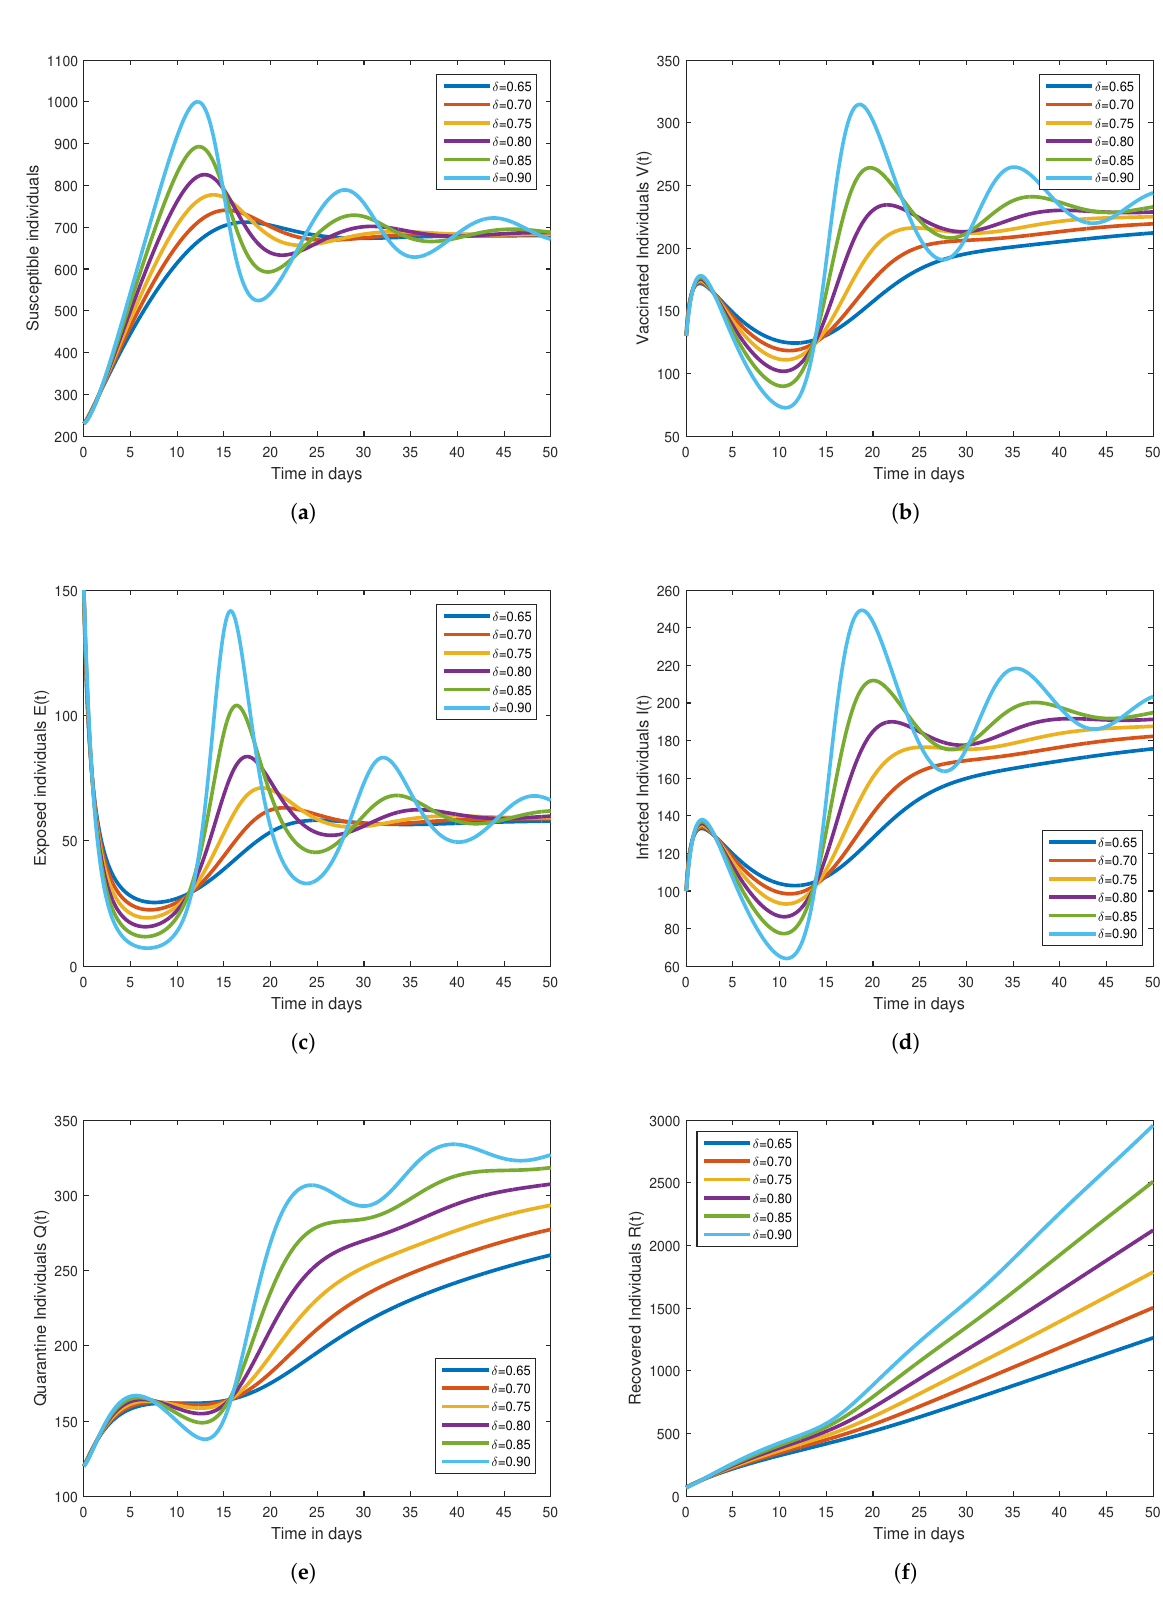
Figure 5. The caputo version of the fractional model’s behavior for each state variable is depicted using the parameter values in the figure. Furthermore, the figures ( a – f ) represents susceptible people S ( t ) , vaccinated people V ( t ) , exposed people E ( t ) , infectious people I ( t ) , quarantined people Q ( t ) , and recovered people R ( t )